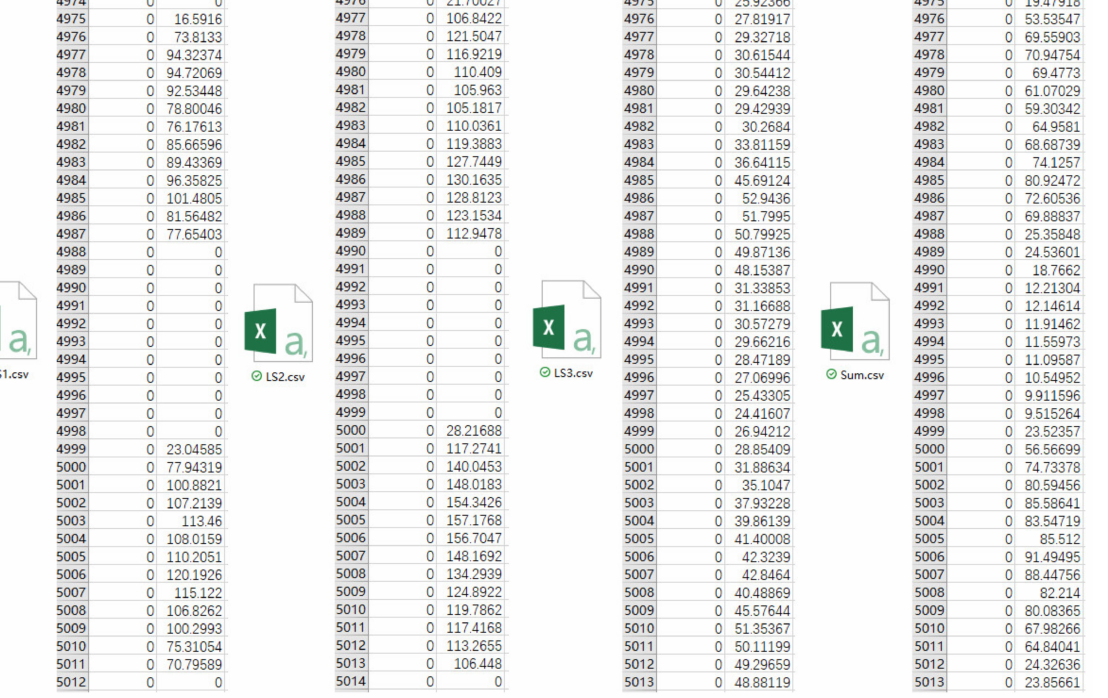
Figure 20. Computation result